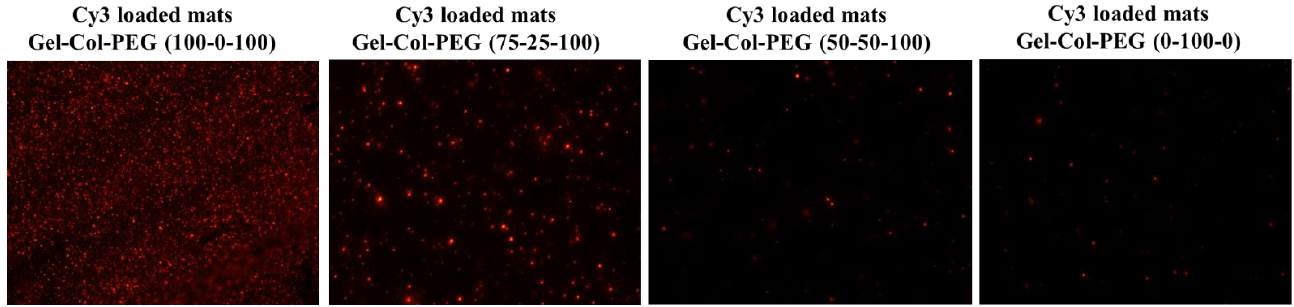
Figure 2. Fluorescence microscopy images of different volume ratio of Gelatin-Collagen-PEG mats with Cy3-labeled pDNA complexes.